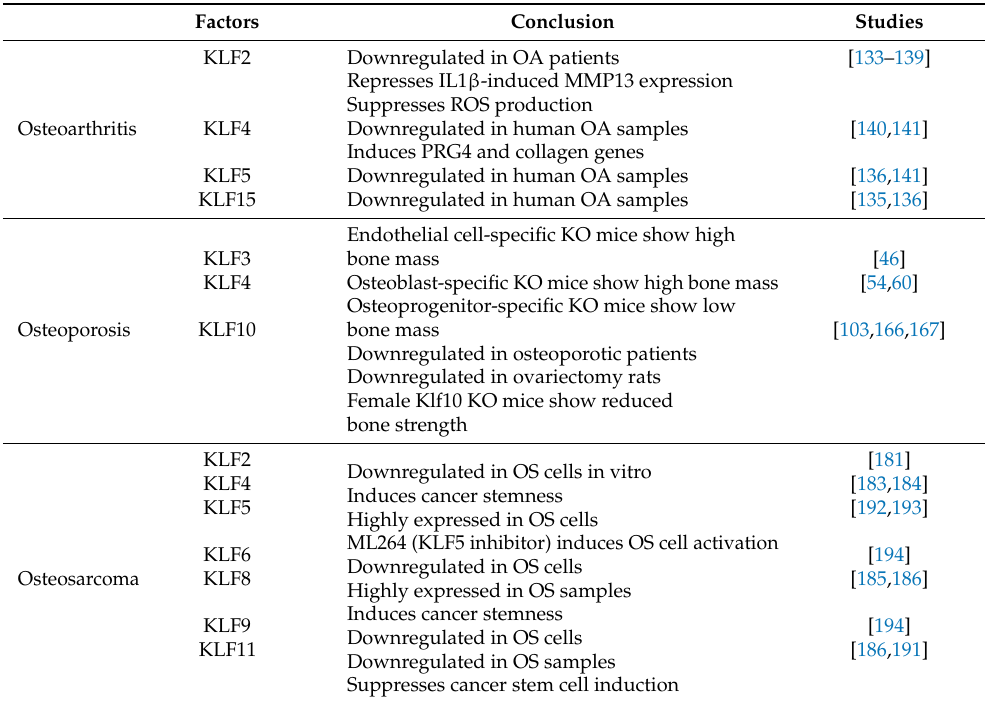
Table 2. Studies of KLFs in bone